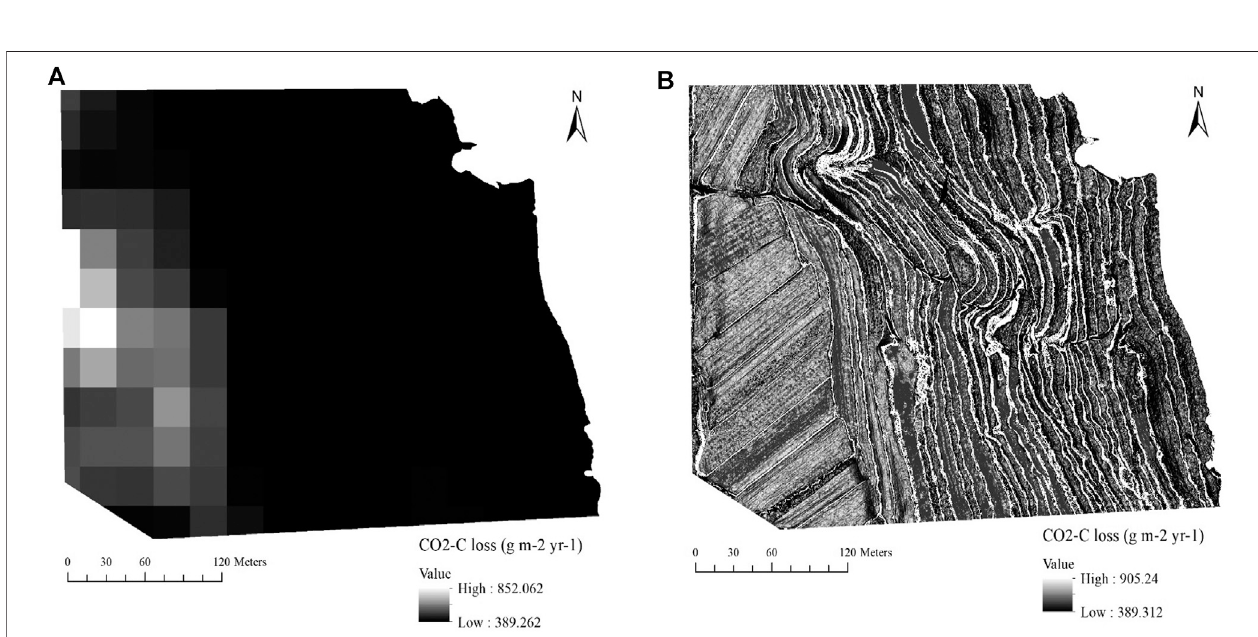
FIGURE5| Comparison ofyearly CO 2 -C emission from differentslopeson aterraced fi eld inthe Wangdong Catchmentcalculatedfrom two digital terrain models. Areas with a gradient of more than 30 ° were not covered by soil anymore, and therefore were manually excluded from the calculations made with the UAV-based DTM.